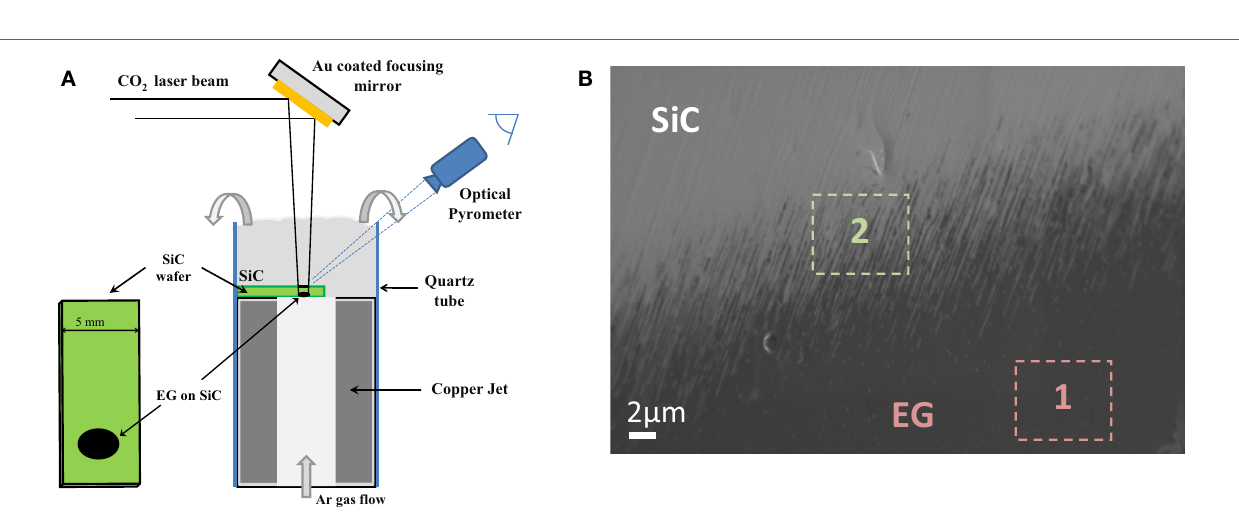
FiGURe 6 | (A) Schematic diagram of the CO 2 laser induced epitaxial growth of graphene on SiC wafers. (B) SEM micrograph showing the formation of epitaxial growth graphene (Zone 1) on 6H- SiC (0001). Reproduced with the permission from Yannopoulos et al. (2012). Copyright 2012,